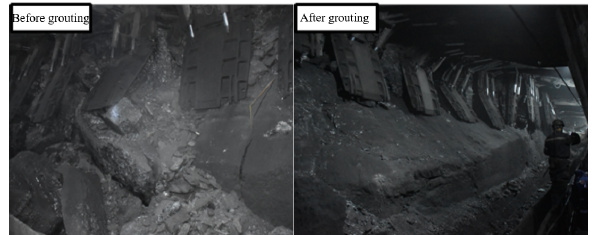
Figure 24. Comparison of coal wall conditions before and after reinforcement.